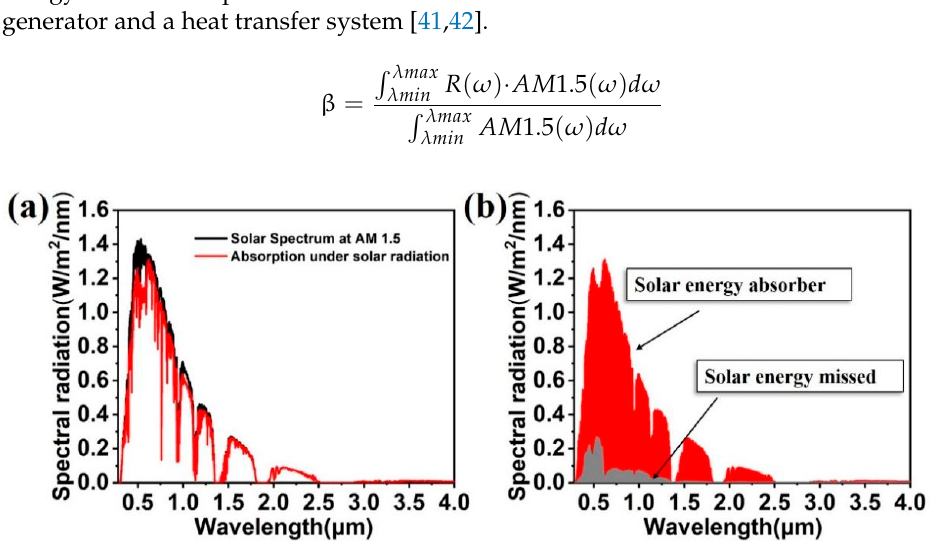
Figure 3. ( a ) Absorption spectrum of colloidal crystal-array-based solar energy absorber under AM 1.5 light source. ( b ) Solar energy absorbed and missed for colloidal crystal-array-based solar energy absorber under AM 1.5 light source.